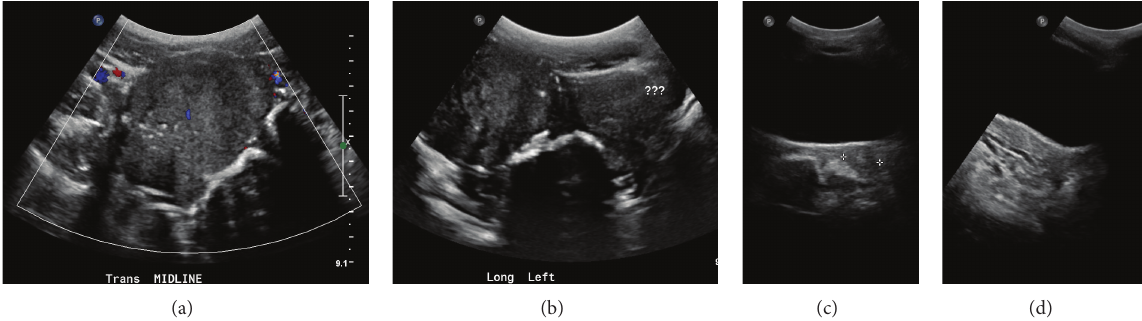
Figure 1: Transabdominal ultrasound imaging. (a), (b) Transverse and longitudinal images of large bilateral solid pelvic masses. Normal ovaries were not identified. (c), (d) Transverse and longitudinal images of a normal prepubertal uterus.